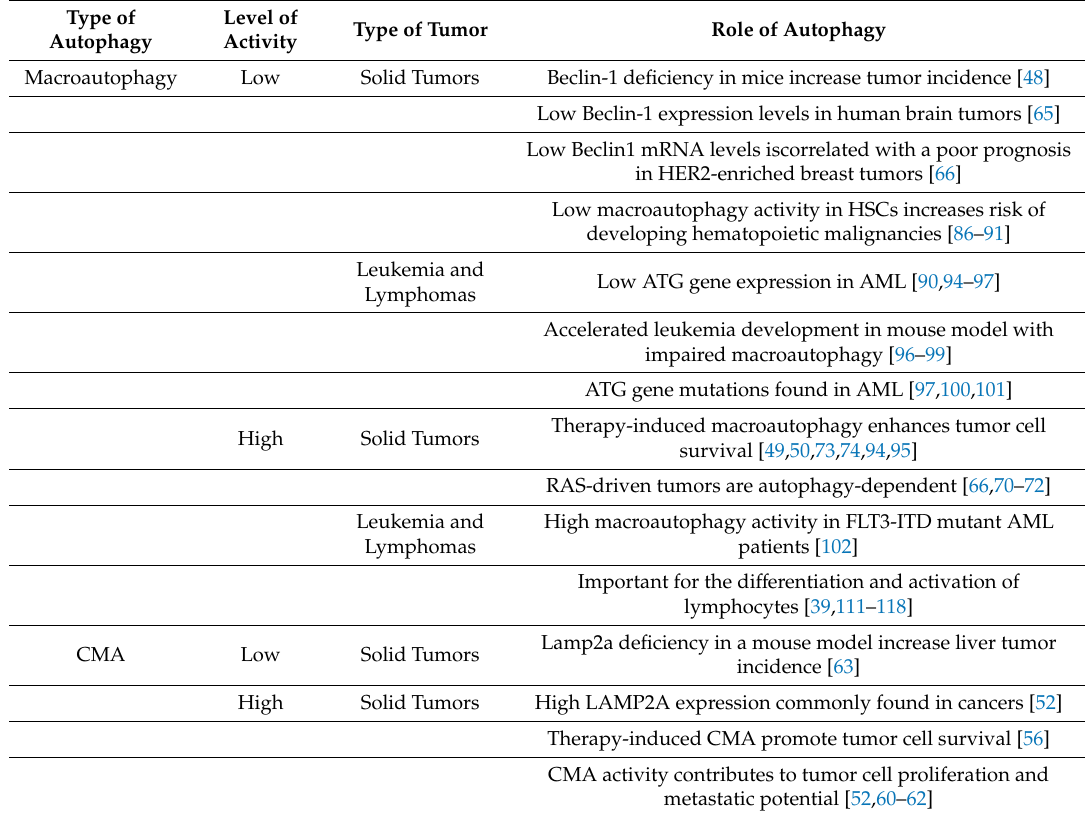
Table 1. Summary of the e ff ect of autophagy on cancer discussed in the present review. For more detailed information, please see the indicated list of recent review articles